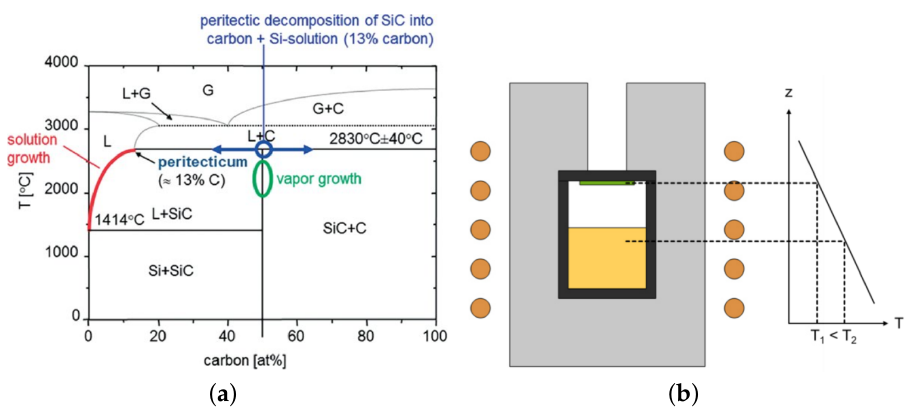
Figure 13. ( a ) Phase diagram of Si and C. ( b ) Schematic setup of a typical PVT growth cell and isolation. With permission from [154].